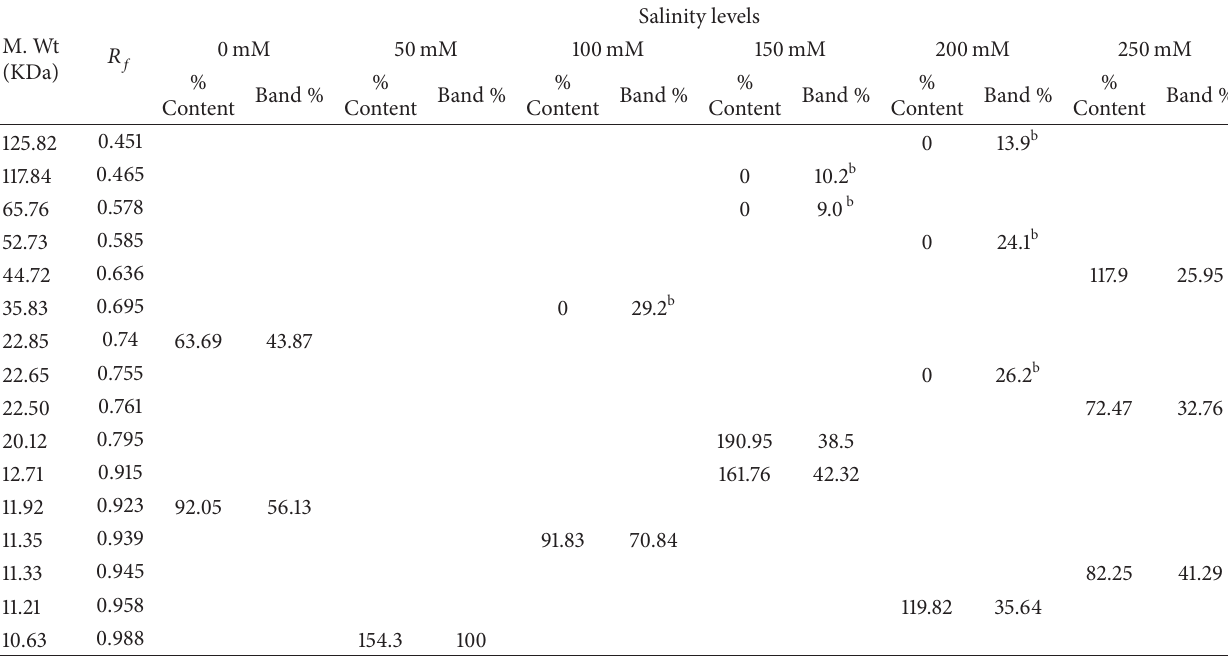
Table 3: Electrophoretic protein pattern of salinity stressed Triticum aestivum seedlings presoaked in 5% Ulva lactuca extract. M.